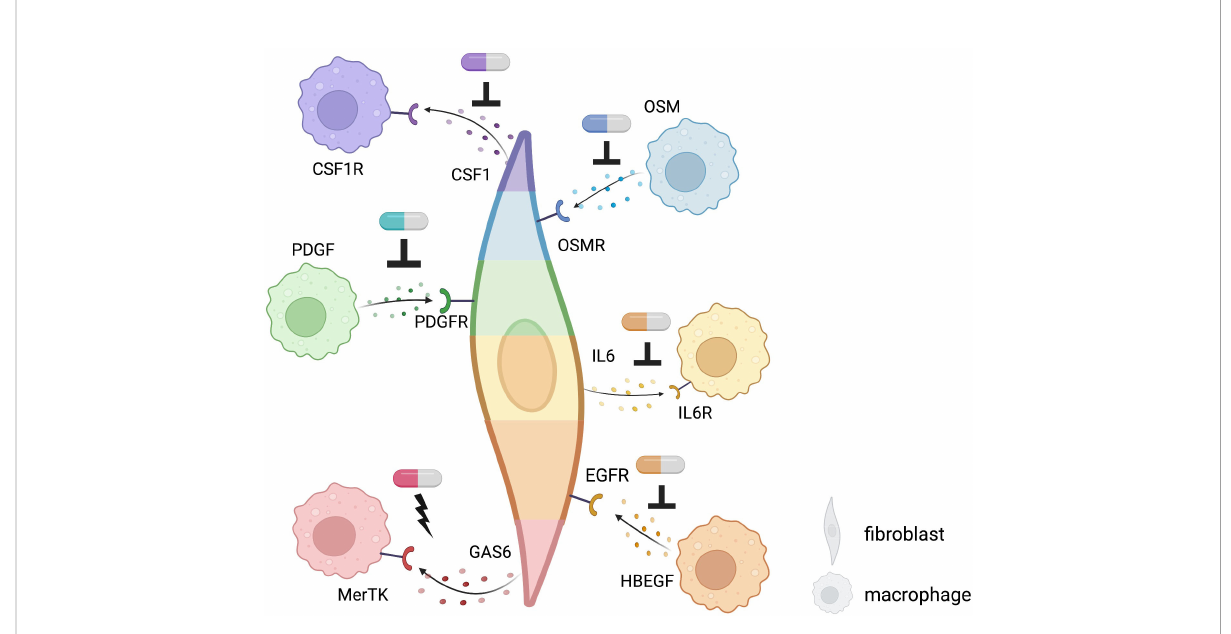
FIGURE 4 Potential targets of fi broblast-macrophage interacting revealed by single-cell computational methods using existing receptor-ligand pairs in IMIDs. Targets of novel therapeutics: potential sites of inhibition are indicated by an upside-down T while sites of activation are indicated by a lightning bolt. Different colors of each fi broblast and macrophage indicate different phenotypes of each cell type. Pill icons indicate potential, experimental, or existing